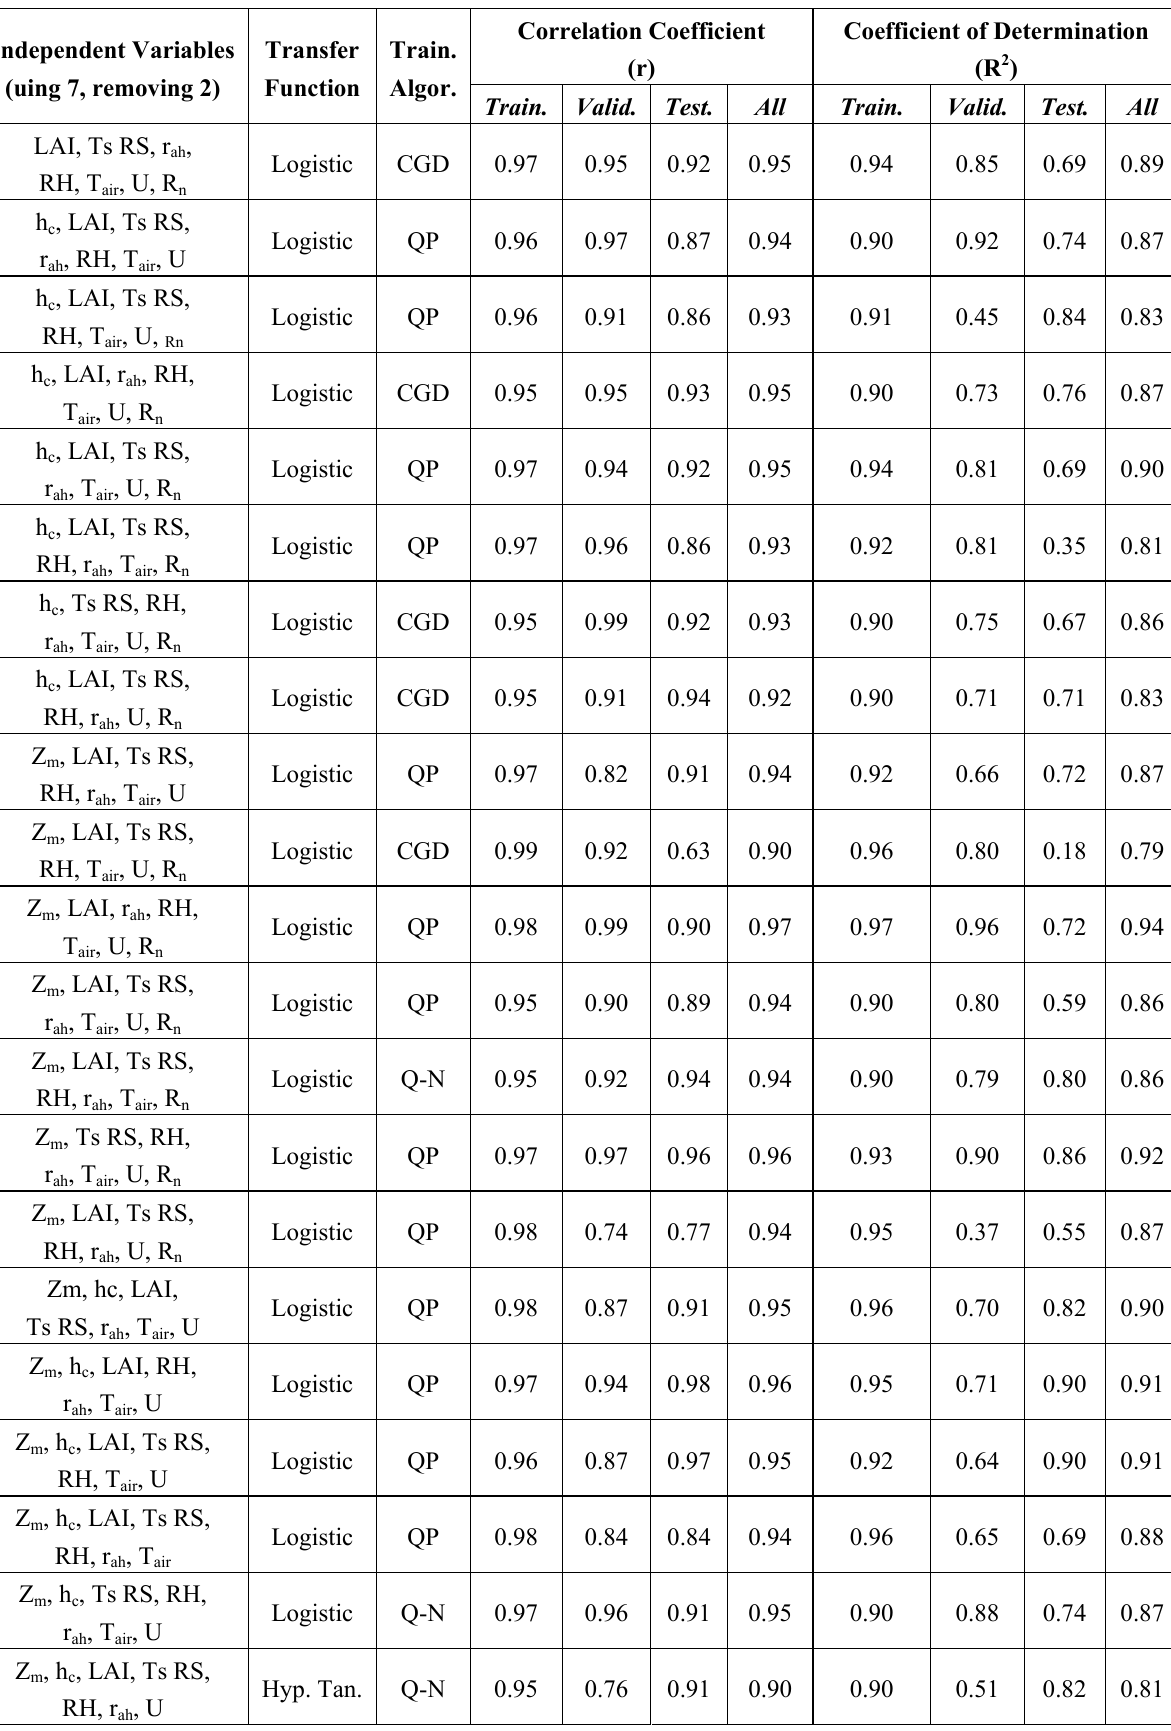
Table A2. Performance of ANN using combinations of seven independent variables. Correlation Coefficient Coefficient of Determination Independent Variables Transfer Train. (r) (R 2 ) (uing 7, removing 2) Function Algor. Train. Valid. Test. All Train. Valid. Test.